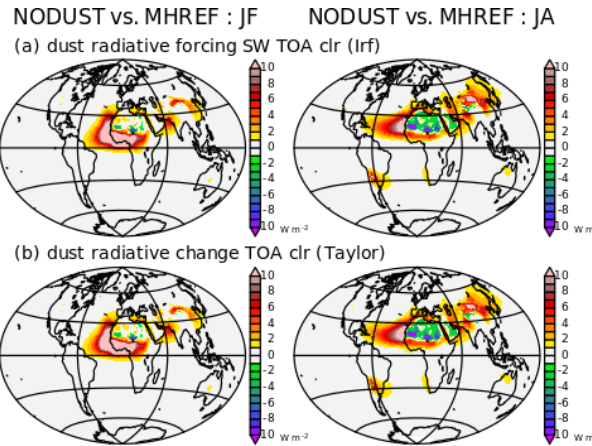
Figure A1. Comparisons of the shortwave radiative forcing esti- mated at the top of the atmosphere for clear sky conditions (SW TOA clr) using (a) the RFMIP protocol to compute instantaneous radiative forcing (IRF) or (b) the simplified Taylor et al. (2007) method from monthly model outputs. This figure only shows the re- sults for NODUST compared to MHREF but the same agreements between the two methods is also found for the other